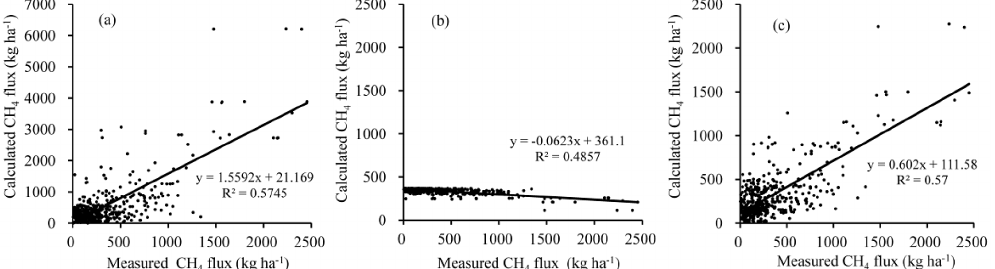
Figure 5. Methane fluxes in the experiments plotted against the respective simulation results through different methods. (a) R1–S0, (b) R2– S0, and (c) M–S0, which are described in Table 1.